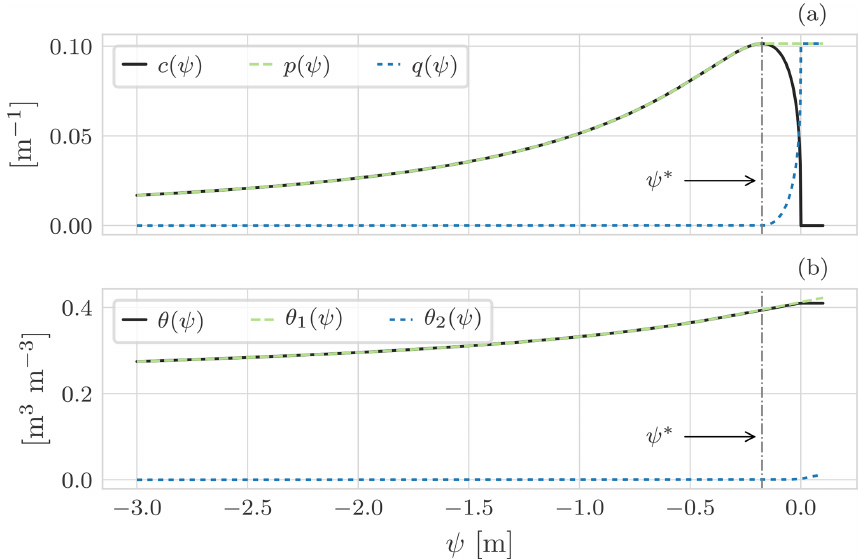
Figure 2. Graphical representation of the Jordan decomposition for soil water content using the SWRC model by Van Genuchten (1980) for a clay loam soil (Bonan, 2019). (a) The Jordan decomposition of c(ψ) as in Eq. (35). For ψ = ψ ∗ , c(ψ) presents a maximum: for ψ < ψ ∗ it is increasing, and for ψ > ψ ∗ it is decreasing. This nonmonotonic behaviour causes problems when solving the nonlinear system. c(ψ) is thus replaced by p(ψ) (in green) and q(ψ) (in blue), which are two monotonic functions whose difference is the original function c . Consequently, (b) θ(ψ) is replaced by θ 1 (ψ) and θ 2 (ψ) (Eq.